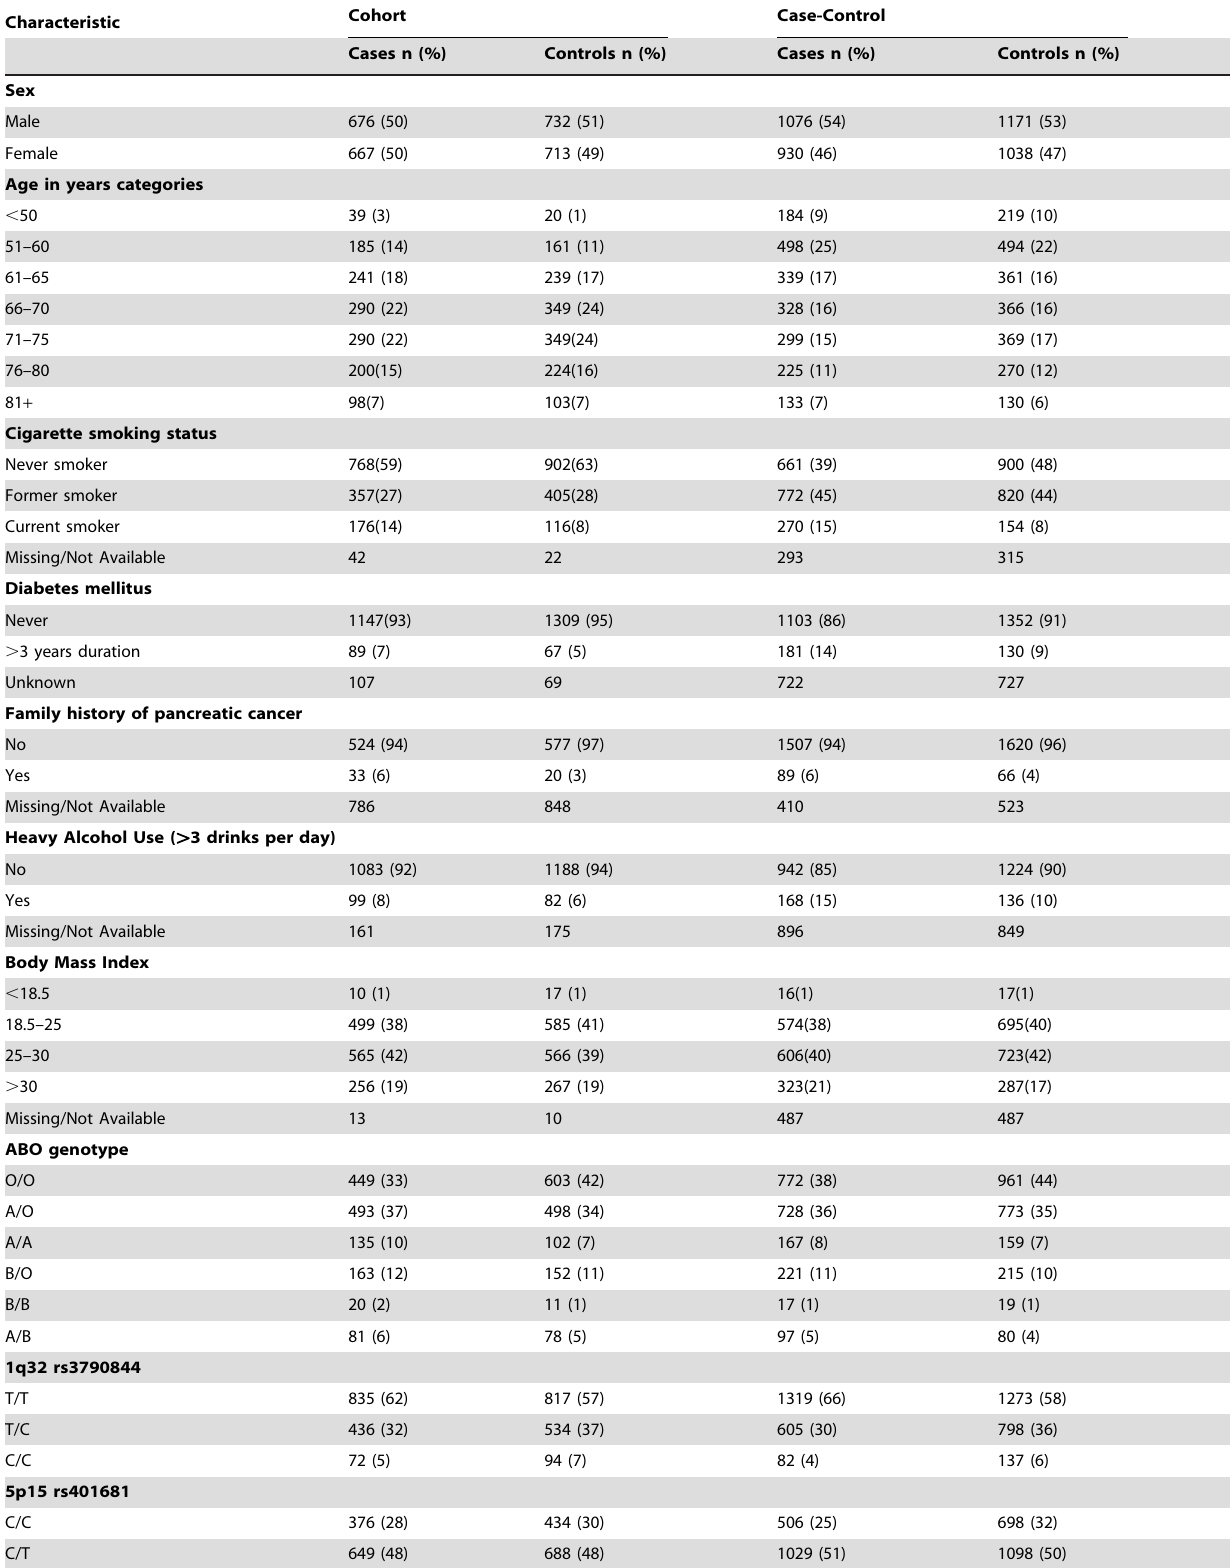
Table 1. Participants’ Characteristics, the PanScan